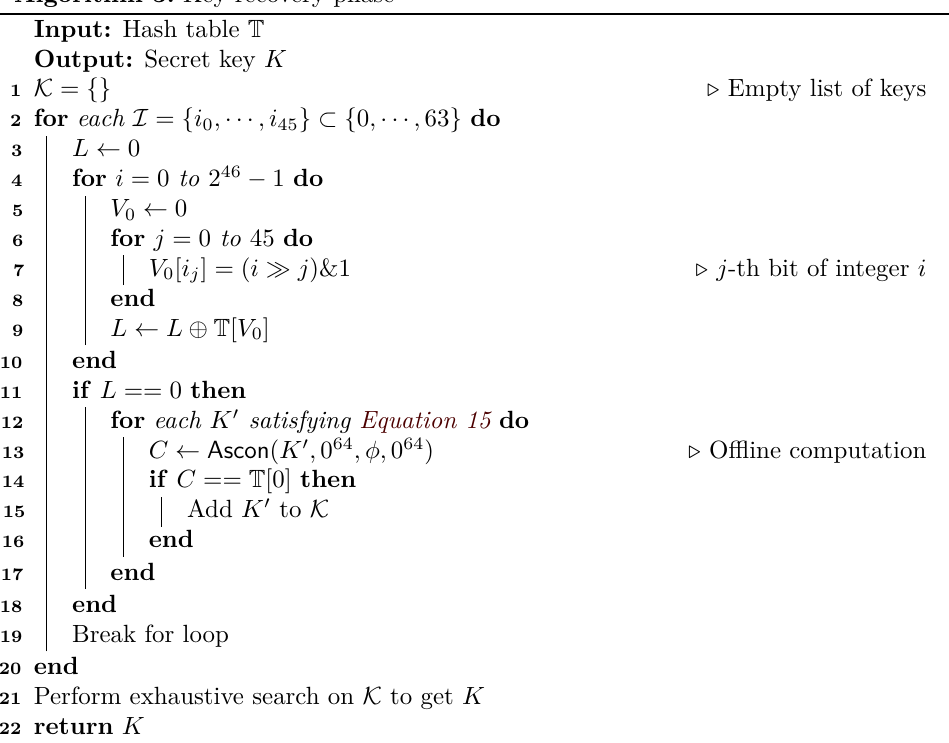
Algorithm 3: Key recovery